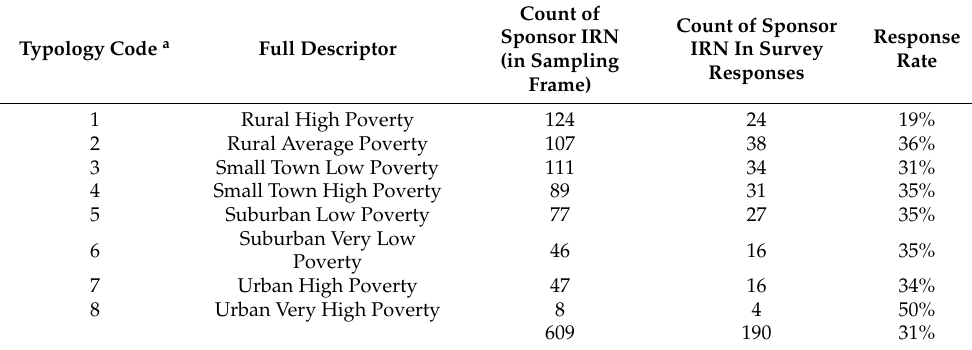
Table 1. Number of Districts Responding to COVID-19 Foodservice Survey by School Typology.